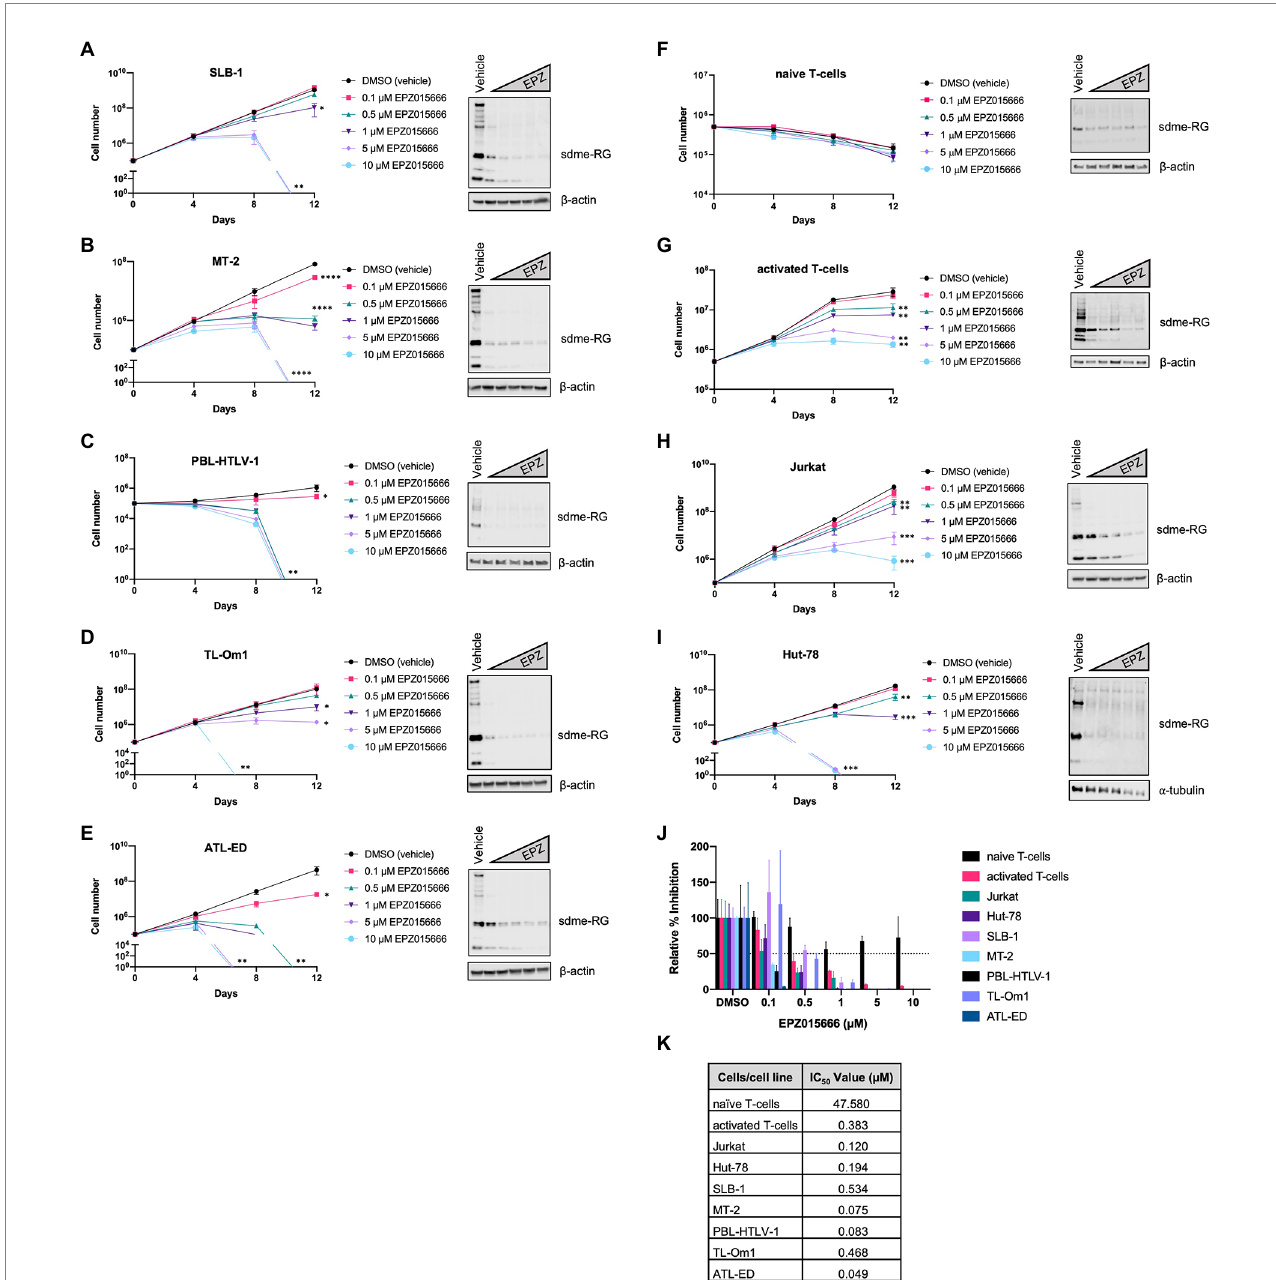
FIGURE 1 EPZ015666 is toxic to transformed T-cells. (A) SLB-1, (B) MT-2, (C) PBL-HTLV-1, (D) TL-Om1, (E) ATL-ED, (F) primary naïve CD4 + T-cells, (G) activated CD4 + T-cells, (H) Jurkat, and (I) Hut-78 cell lines were treated with titrating doses of EPZ015666 (0.1–10 μ M) for 12 days (left panels). Viable cells were counted using Trypan blue dye exclusion. Each data point represents the mean for three replicates. Ordinary one-way ANOVA with Dunnett’s multiple comparison was used to determine significant differences between vehicle and EPZ015666-treated cells; p < 0.05 (*), p < 0.01 (**), p < 0.005 (***), p < 0.0001 (****). A portion of the cells were collected 4 days after EPZ015666 treatment and subjected to immunoblot analysis to compare the levels of Symmetric Di-Methyl Arginine Motif (sdme-RG) expression (right panels). β -actin and α -tubulin were used as loading controls. (J) Relative percent inhibition was calculated after 12 days of EPZ015666 treatment. (K) EPZ015666 IC 50 values were calculated for each cell